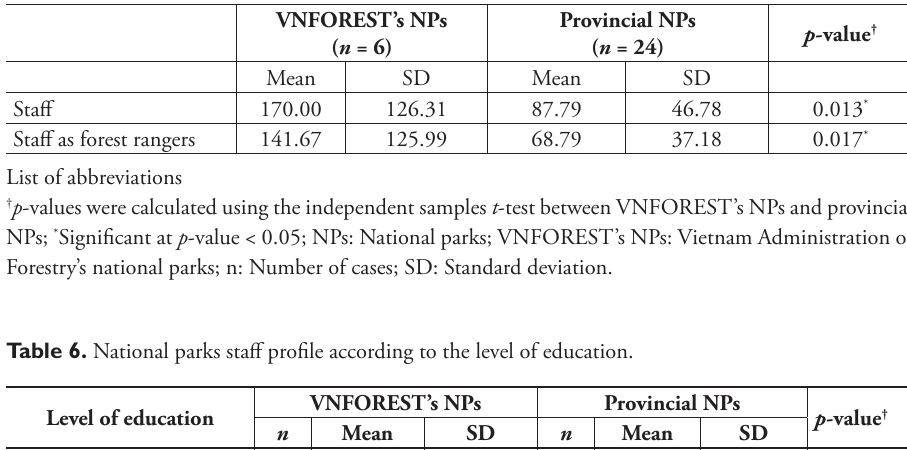
Table 5. Staff of national parks.